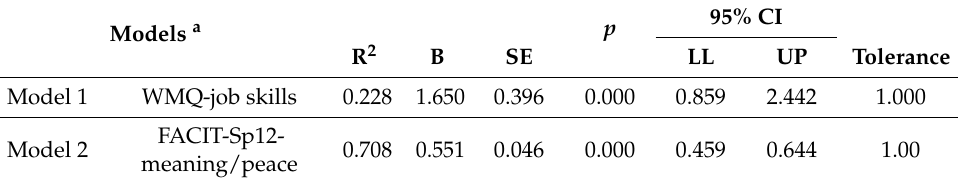
Table 3. Predictive models of recovery.